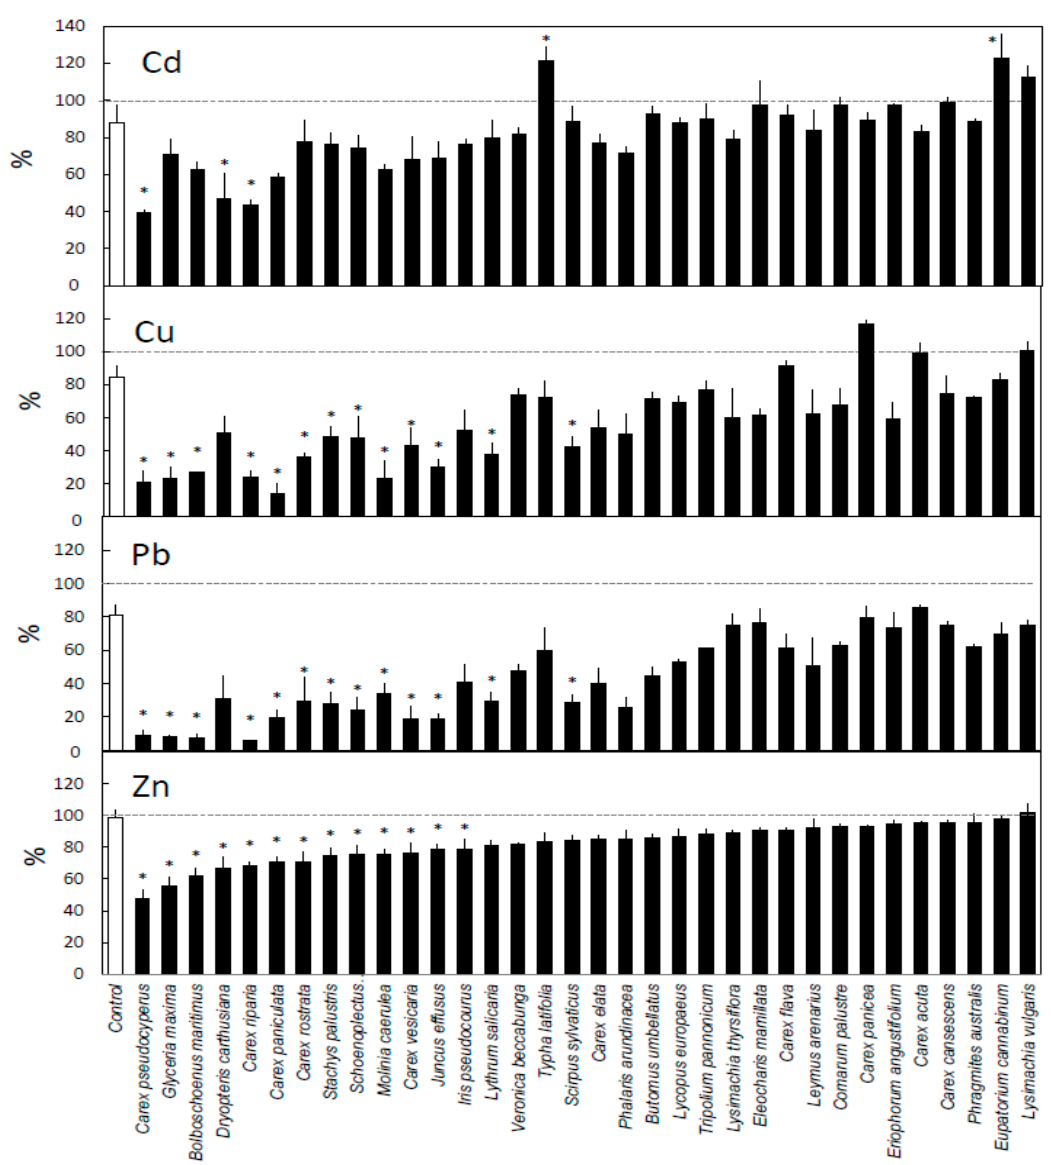
Figure 1. Remaining metal in solution after 0.5 h of exposure. Pairwise comparisons made within each metal between no-plant control (white bar) and every species (black bars), where * = p < 0.05. Dotted line represents initial concentration (at 0 h = 100%). n = 3, ±SE for all plants, n = 21, ±SE, for no-plant control.